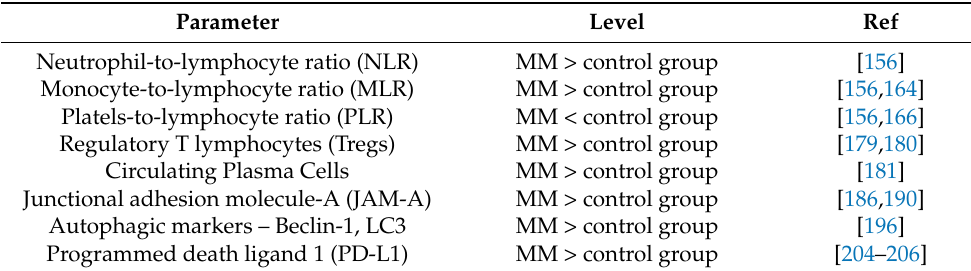
Table 2. Schematic interpretation of the correlation of different parameters in MM patients vs. healthy